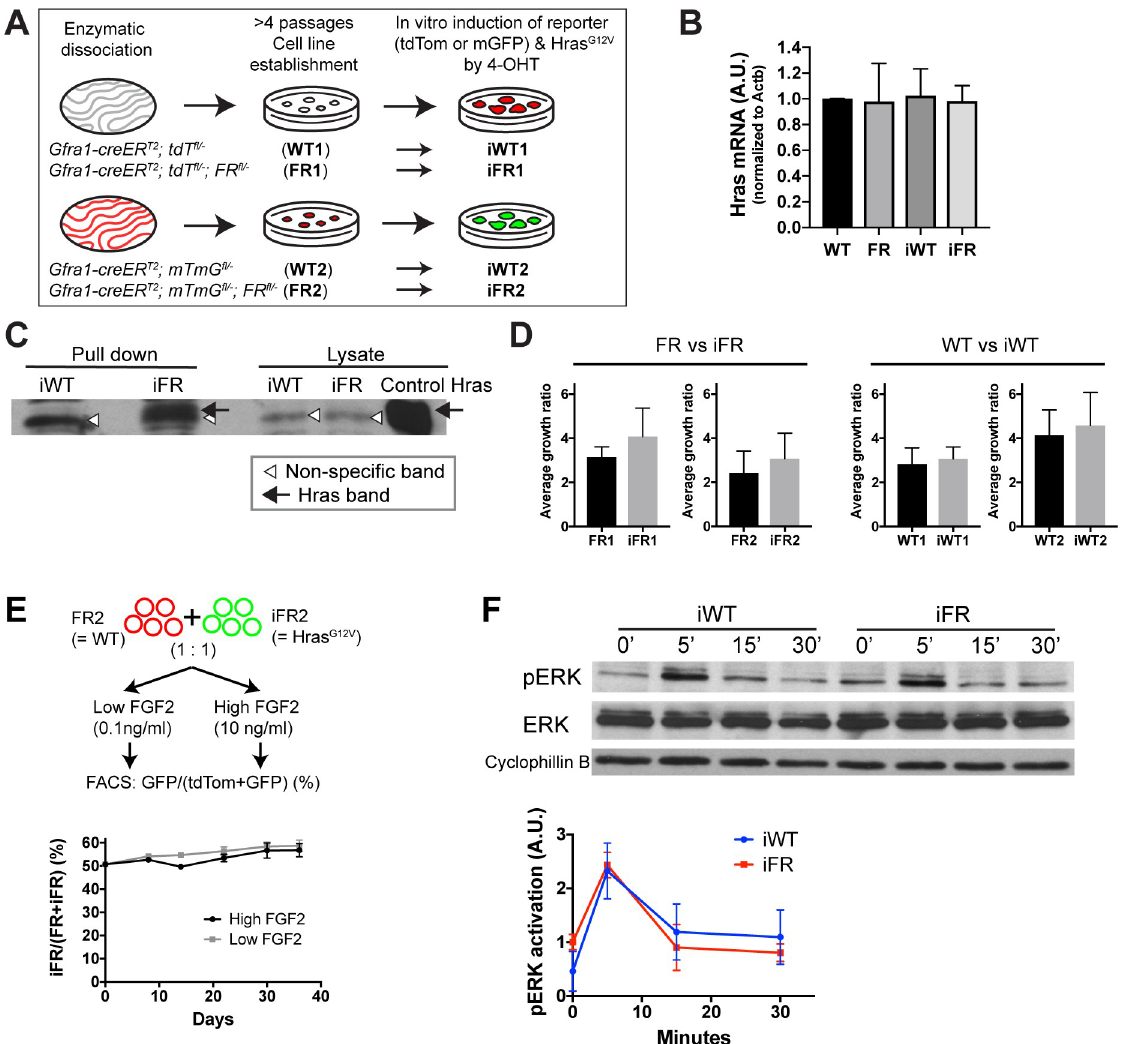
Fig 7. Effect of Hras G12V on function of cultured SSCs. A. Derivation of cell lines and in vitro induction of Hras G12V . Two different adult cell line pairs (WT & FR) each from the different reporter systems were established. Dissociated testicular cells were plated and colonies were picked, enriched, and serially passaged on feeders. B. Hras transcript levels (RT-qPCR) in different cell lines. Primers were designed to recognize a common region shared by WT and Hras G12V . N = 3 experiments. C. Western blot for HRAS in SSCs from iWT and iFR. Activated HRAS proteins were pulled down with RAF1 RAS-binding domain and probed by an anti-HRAS antibody (left). In iFR, activated HRAS was observed (black arrow). Open triangle denotes non-specific band. Total lysates (right) from iWT, iFR, and control Hras were probed concurrently. Lysate from Hras -overexpressing 293T cells served as a positive control. D. Growth ratio of different SSC cell lines. Shown are average weekly growth ratios (4 passages over a month). In all cases, the growth ratios of induced lines were not different from their parental cell lines. E. In vitro competition assay. FR2 (tdTomato+) and iFR2 (GFP+) cells were mixed at 1:1 ratio, allocated to low (0.1 ng/ml) and high (10 ng/ml) FGF2 media, and passaged 5 times. At each passage, GFP+ cell ratios were measured by FACS. F. Phosphorylation of ERK after FGF2 stimulation. Top: Representative western blot (top) from iWT and iFR for pERK, ERK, and loading control, cyclophilin B. Bottom: Quantification based on average densitometric values of western blots from three different sets of clones (bottom). At 0’, iFR exhibited more activation of pErk than iWT (t-test; P = 0.08; n = 3), whereas no significant difference was seen at 5’, 15’ and 20’ between iWT and iFR.